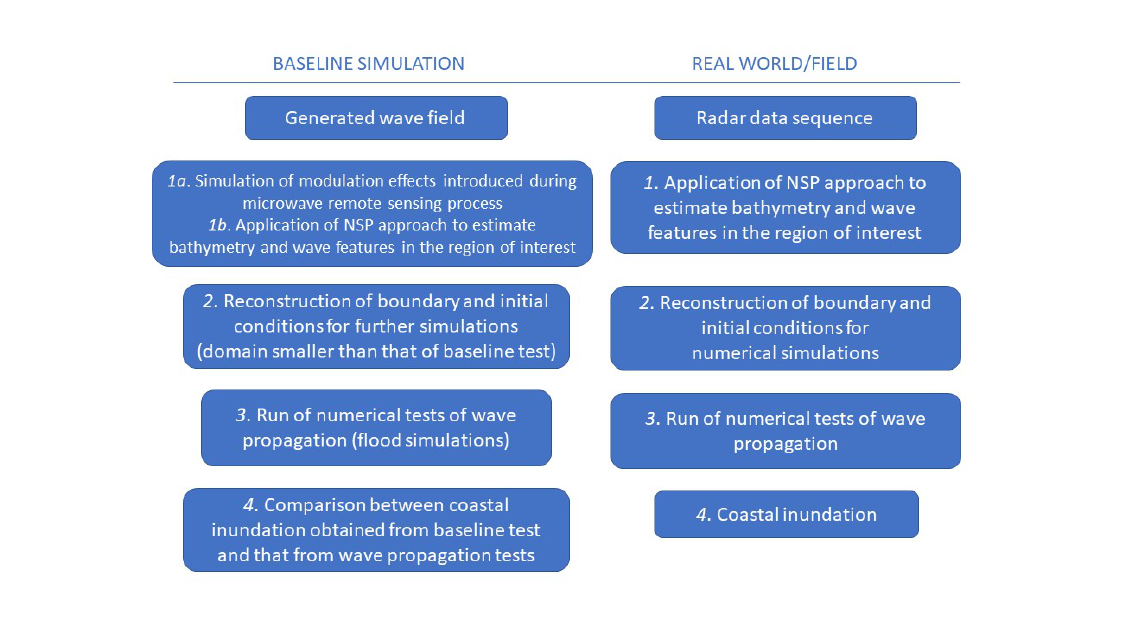
Figure 1. Sketch of the methodology applied in the present work ( left ) or to be applied to the real world ( right